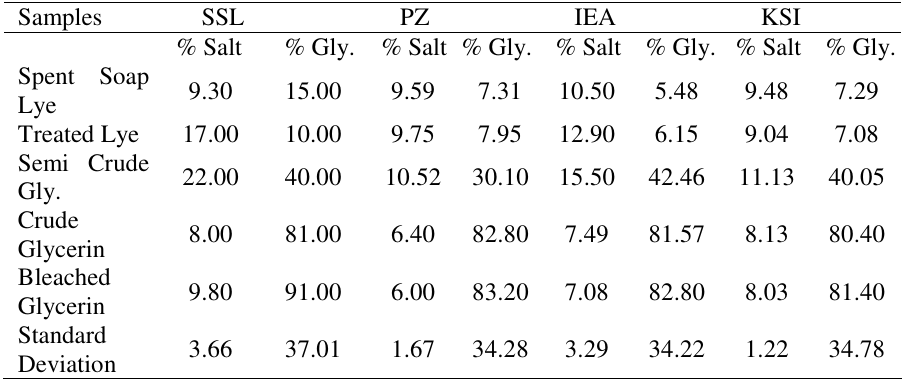
Table 3. Percentage concentrations of salt and glycerin and their standard deviations recovered from soap lye for different samples (SSL, PZ, IEA and KSI)